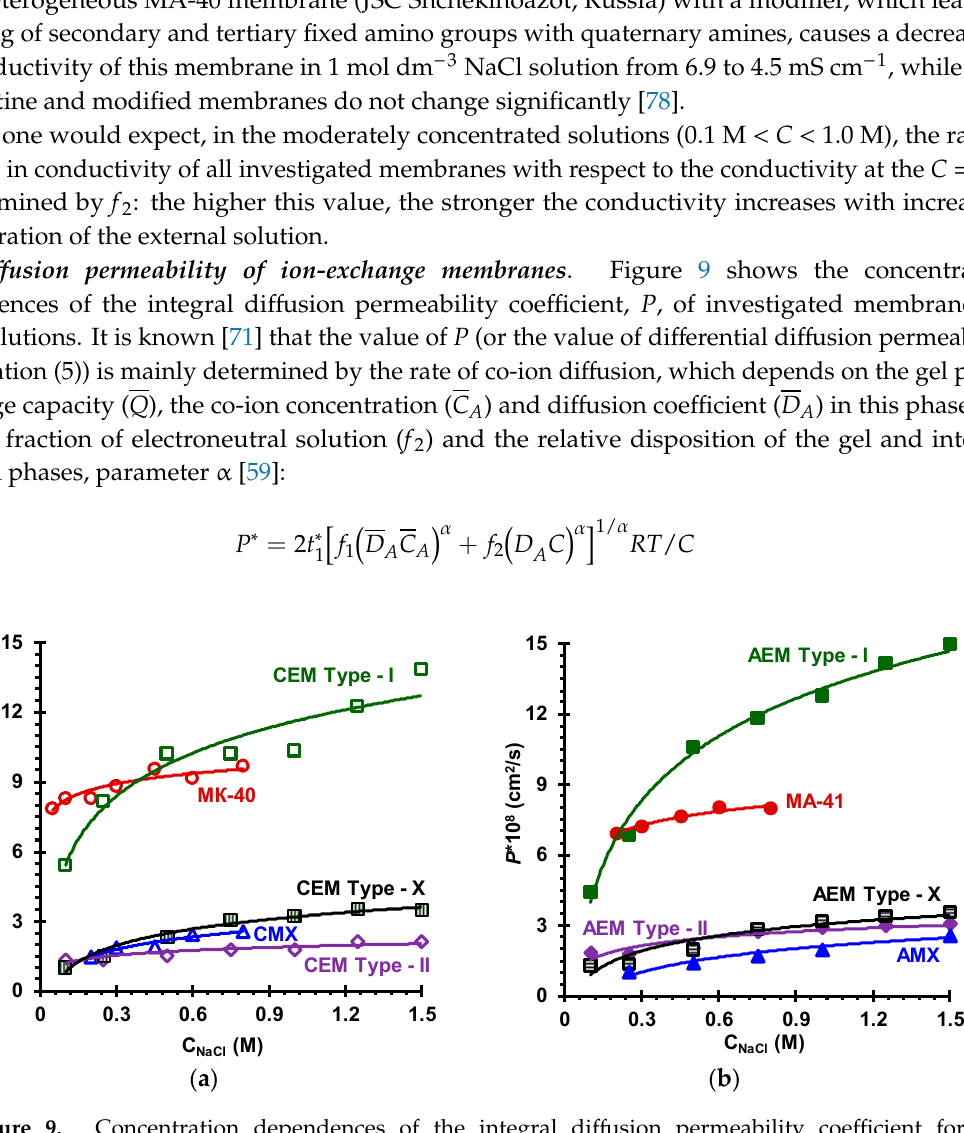
Figure 9. Concentration dependences of the integral diffusion permeability coefficient for cation-exchange ( a ) and anion-exchange membranes ( b ) in NaCl solutions.